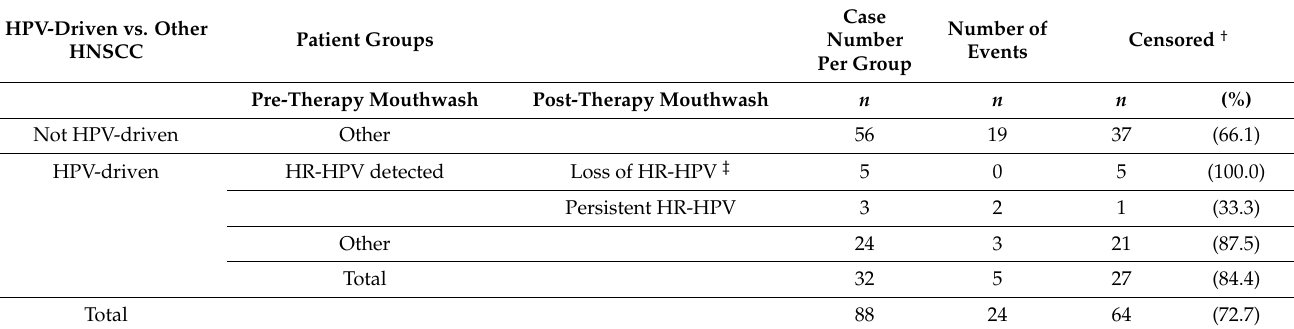
Table 4. Numbers of patients with HPV-driven and other head and neck squamous cell carcinoma (other), as well as recurrences according to detection of HR-HPV DNA in post-therapy